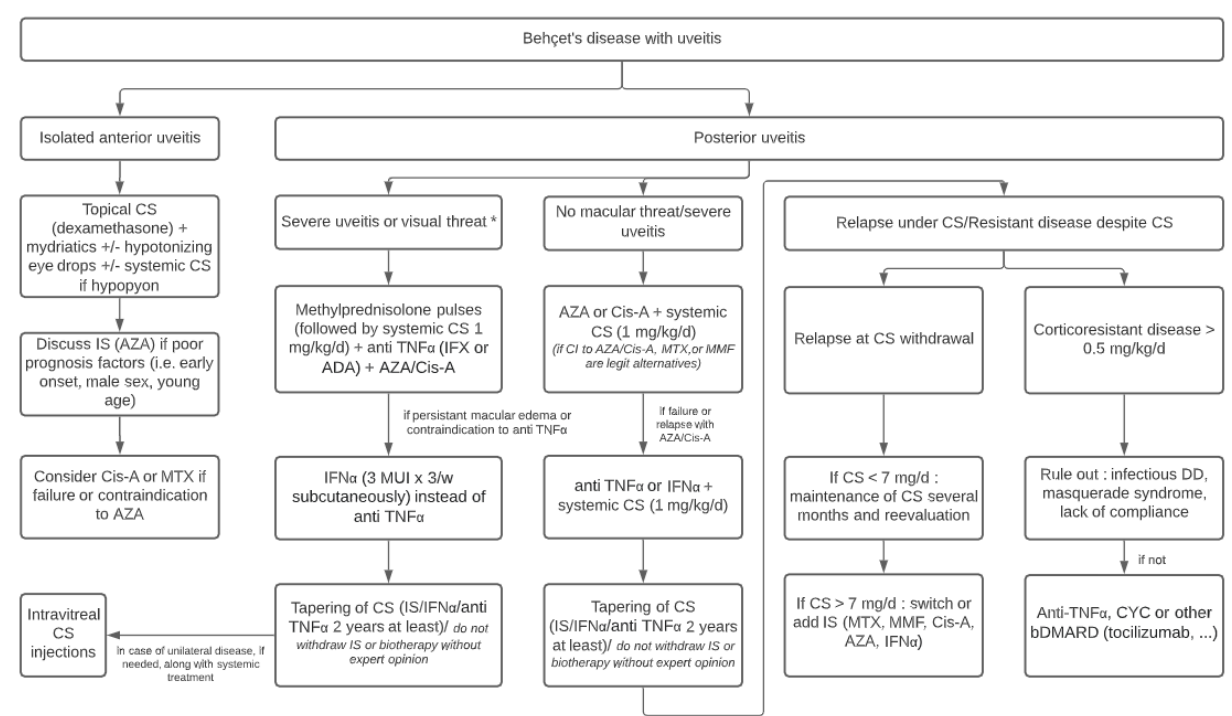
Figure 6. Algorithm for management of Behçet’s uveitis. Abbreviations: ADA: adalimumab; AZA: azathioprine; bDMARD: biologic disease modifying anti rheumatic drugs; Cis-A: ciclosporine A; CS: corticosteroids; CYC: cyclophosphamide; IFN: interferon; IFX: infliximab; IS: immunosuppressants; MMF: mycophenolate mofetil; MTX: methotrexate; MUI: million international units; TNF: tumor necrosis factor. * optic neuropathy, macular edema with visual acuity <20/200 or vasculitis with retinal ischemia.